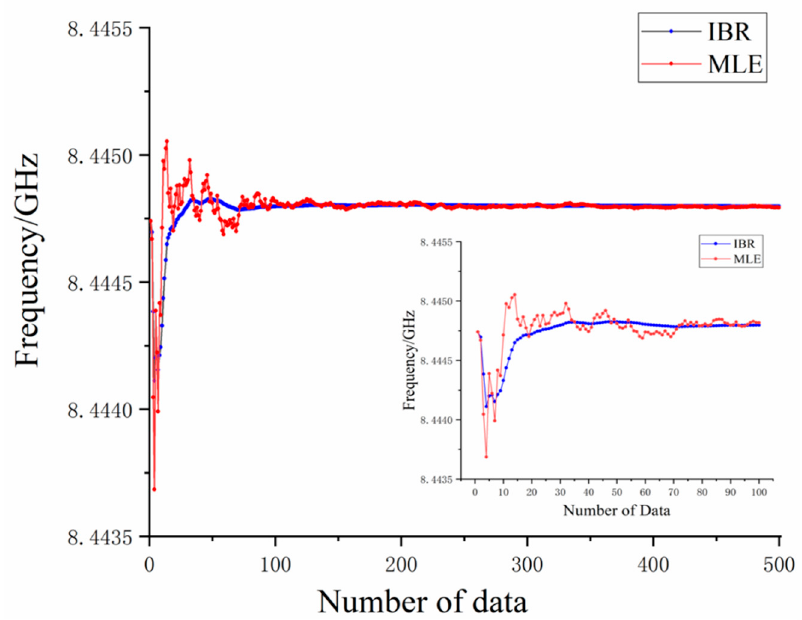
Figure 4. Estimated frequency at the valley of simulation signals.